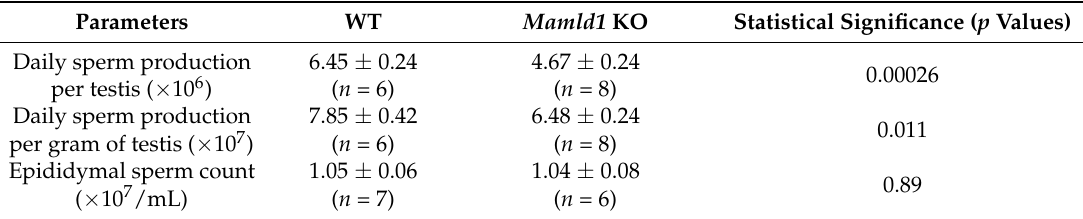
Table 2. Sperm analysis of mice at 8 weeks of age.